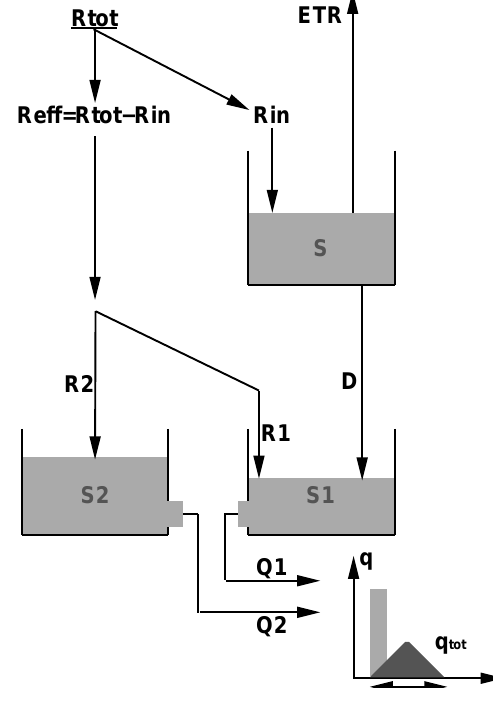
Fig. 2. Schematic of the HBV